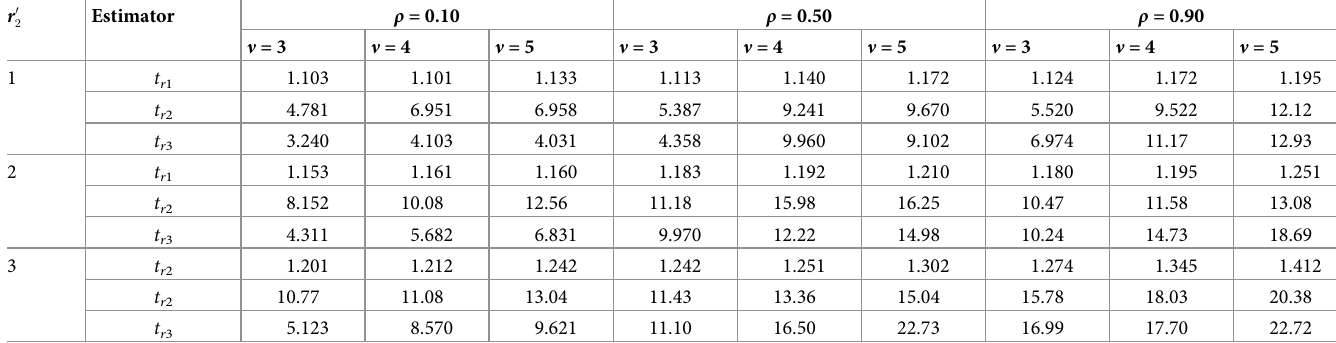
Table 3. RE of proposed class of estimators for Situation-I when k = 4. r 0 2